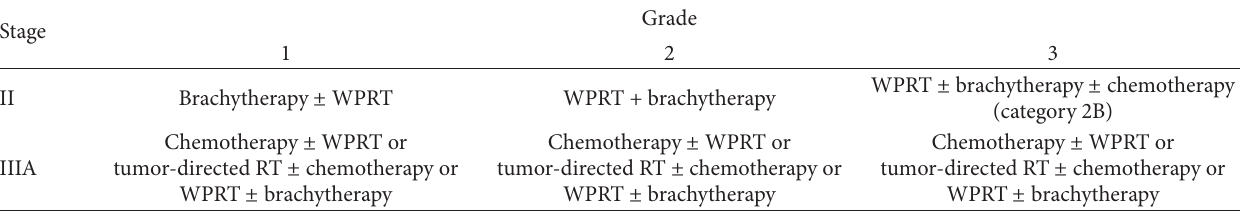
Table 8: Adjuvant treatment of advanced local endometrial cancer.